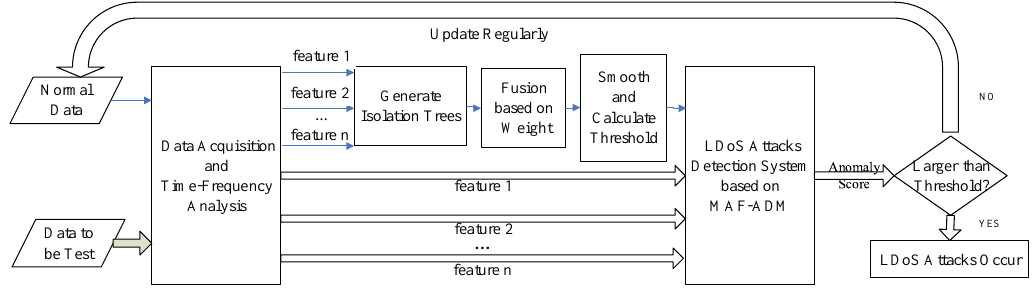
Figure 7. The processing flow of LDoS detection method based on